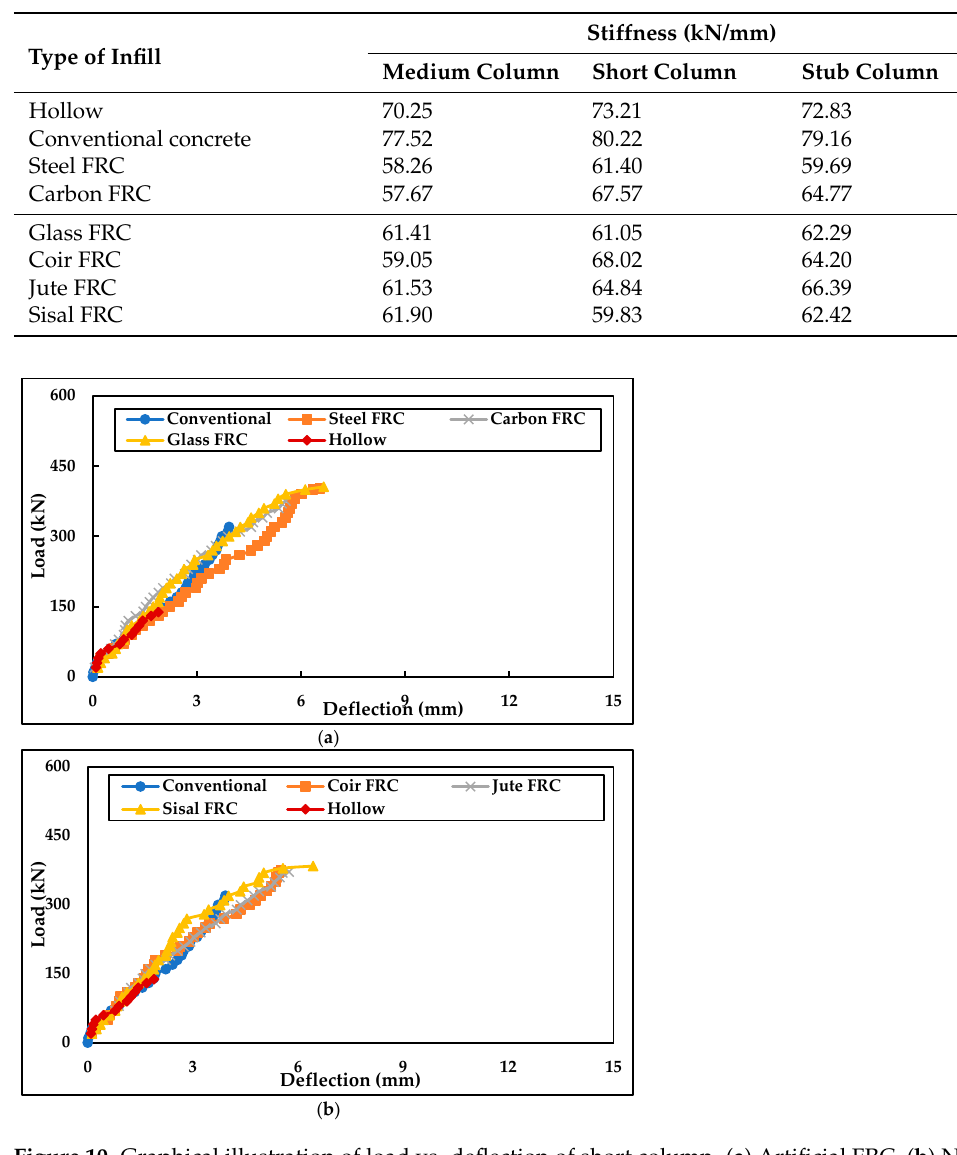
Table 3. Stiffness for various concrete-filled steel tubular columns.